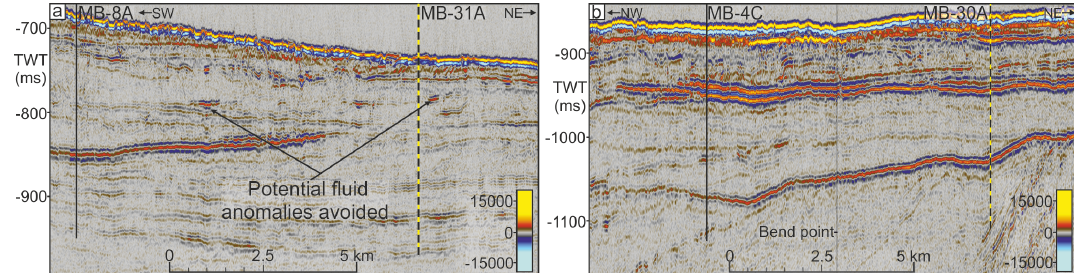
Figure 11. Targets III and IV. Seismic cross sections from the LAKO UHR survey that highlight the glacigenic stratigraphy of Targets III (a) and IV (b) as well as the locations of potential fluid anomalies and sites MB-31A (primary), MB-8A, MB-30A (primary) and MB-4C (alternate). The locations of both panels (a) and (b) are shown in Fig. 3, and uninterpreted versions are provided in Fig.